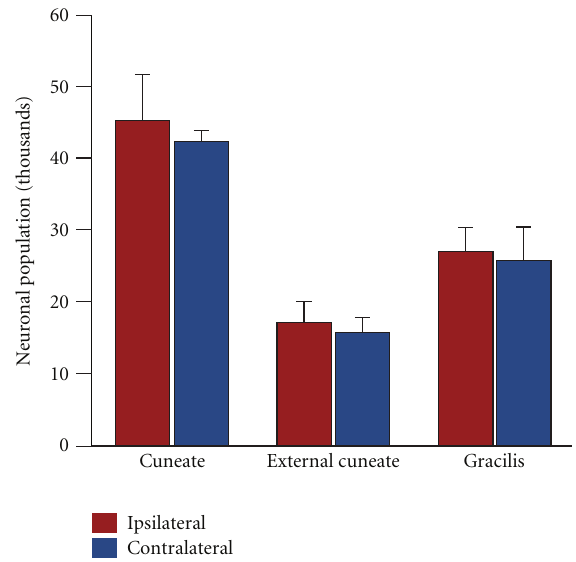
Figure 7: Design-based stereology neuronal counts in the dorsal column nuclei. There were no neuronal population di ff erences between ipsi- and contralateral subdivisions of the dorsal column